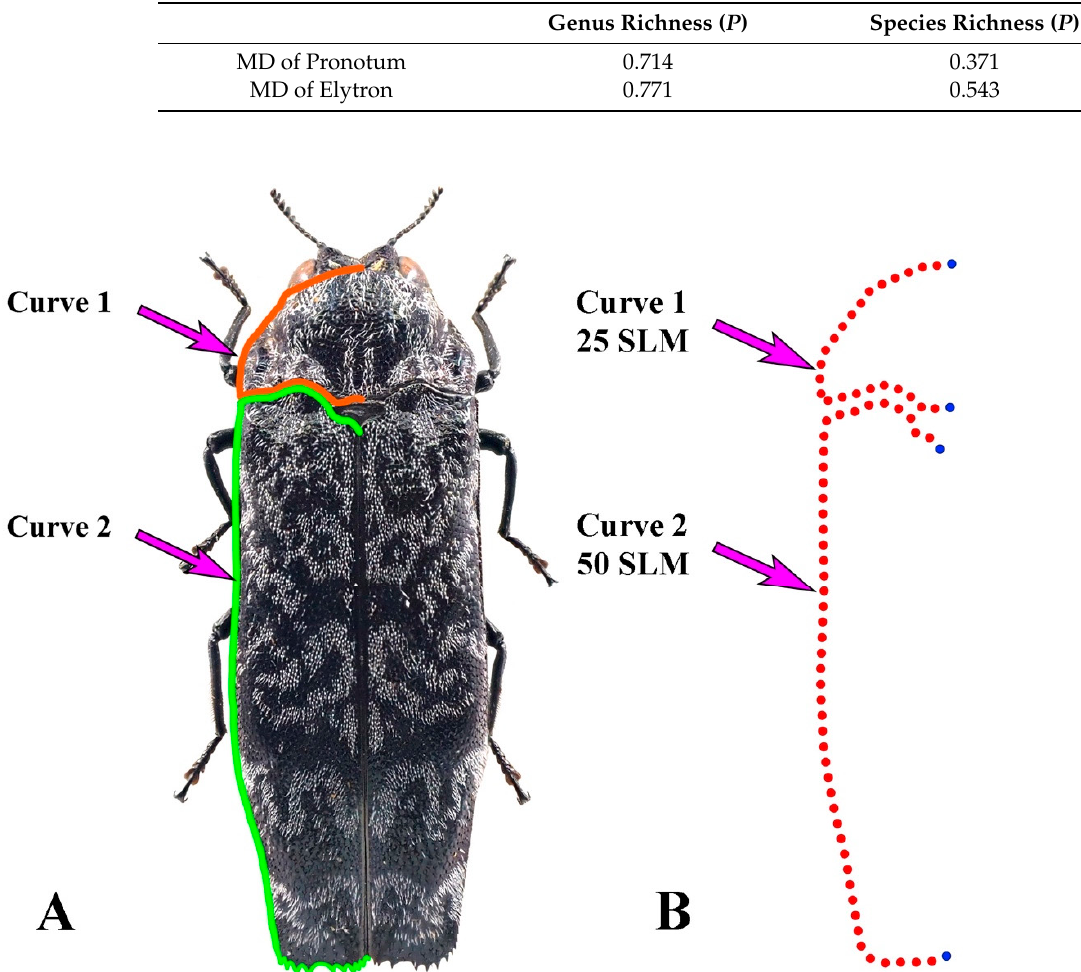
Table 3. Spearman correlation coefficient between test parameters.